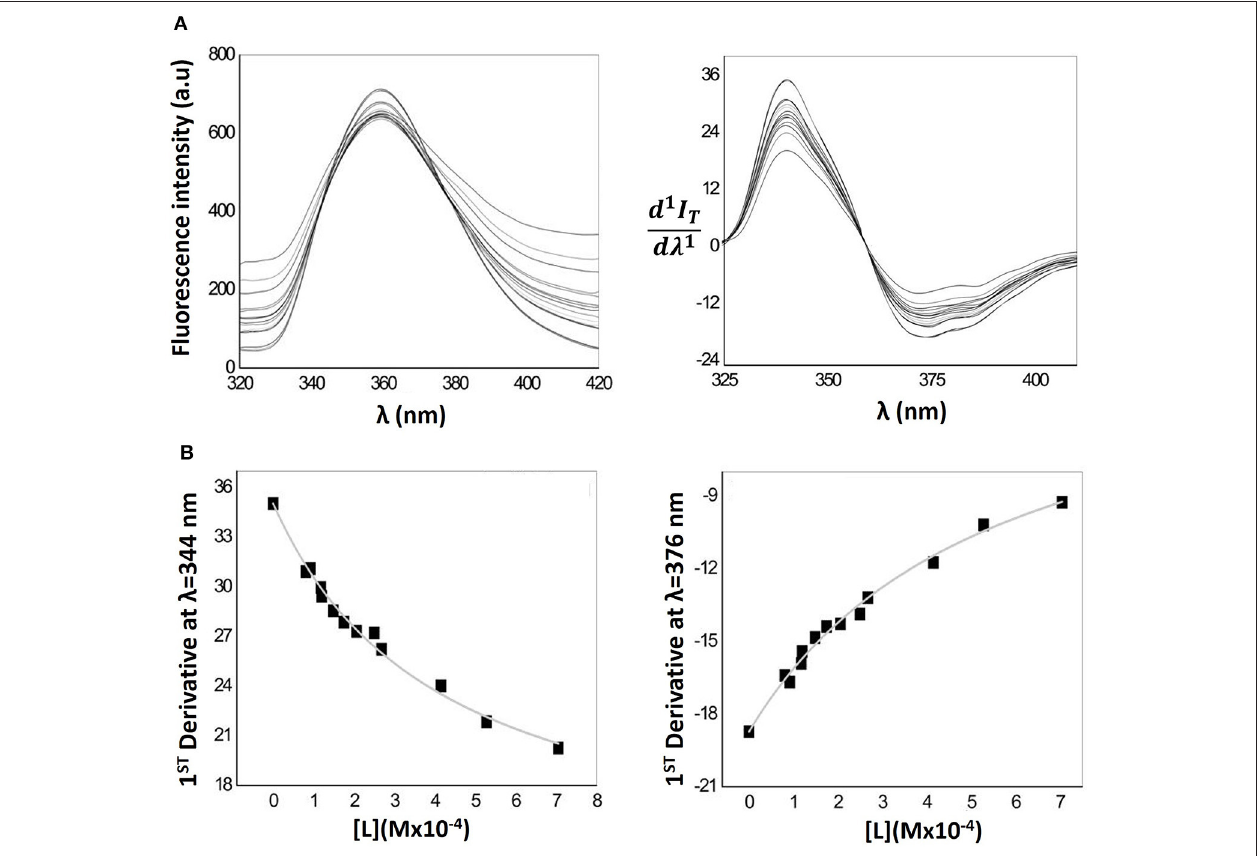
FIGURE 6 | (A) Fluorescence emission spectra (left) of MLVs of EPC (25–300 µ M) containing a fixed Naproxen concentration (0.4 µ M) in Hepes buffer pH = 7.4 and I = 0.1M and respective first derivative of Naproxen fluorescence emission spectra (right). (B) Correspondent nonlinear fitting (Equation 4) of derivative fluorescence emission values at λ max = 344nm (left) and at λ min = 376nm (right) as a function of lipid concentration.